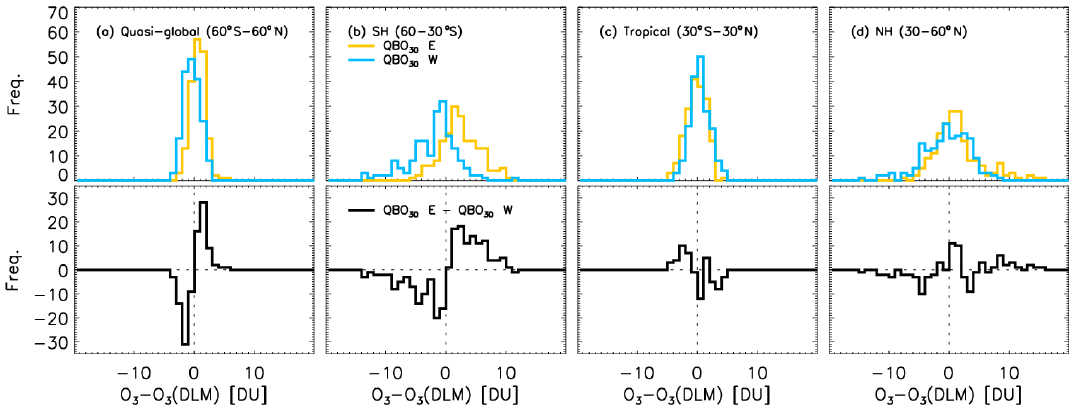
Figure 3. (Upper row) Histograms of ozone anomalies relative to the DLM non-linear trend line in Fig. 2 for months when the QBO at 30hPa is either in an easterly (yellow) or westerly (blue) phase: (a) quasi-global (60 ◦ S–60 ◦ N), (b) Southern Hemisphere (60–30 ◦ S, 147– 30hPa), (c) tropics (30 ◦ S–30 ◦ N, 100–30hPa), and (d) Northern Hemisphere (30–60 ◦ N, 147–30hPa). (Lower row) Difference between QBO easterly and westerly histograms from the upper